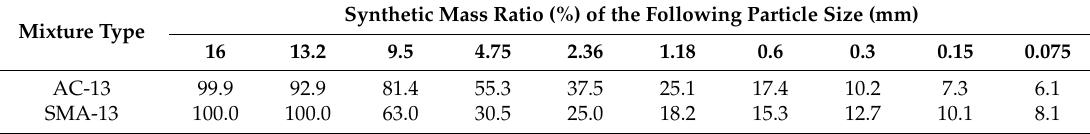
Table 3. Asphalt mixture